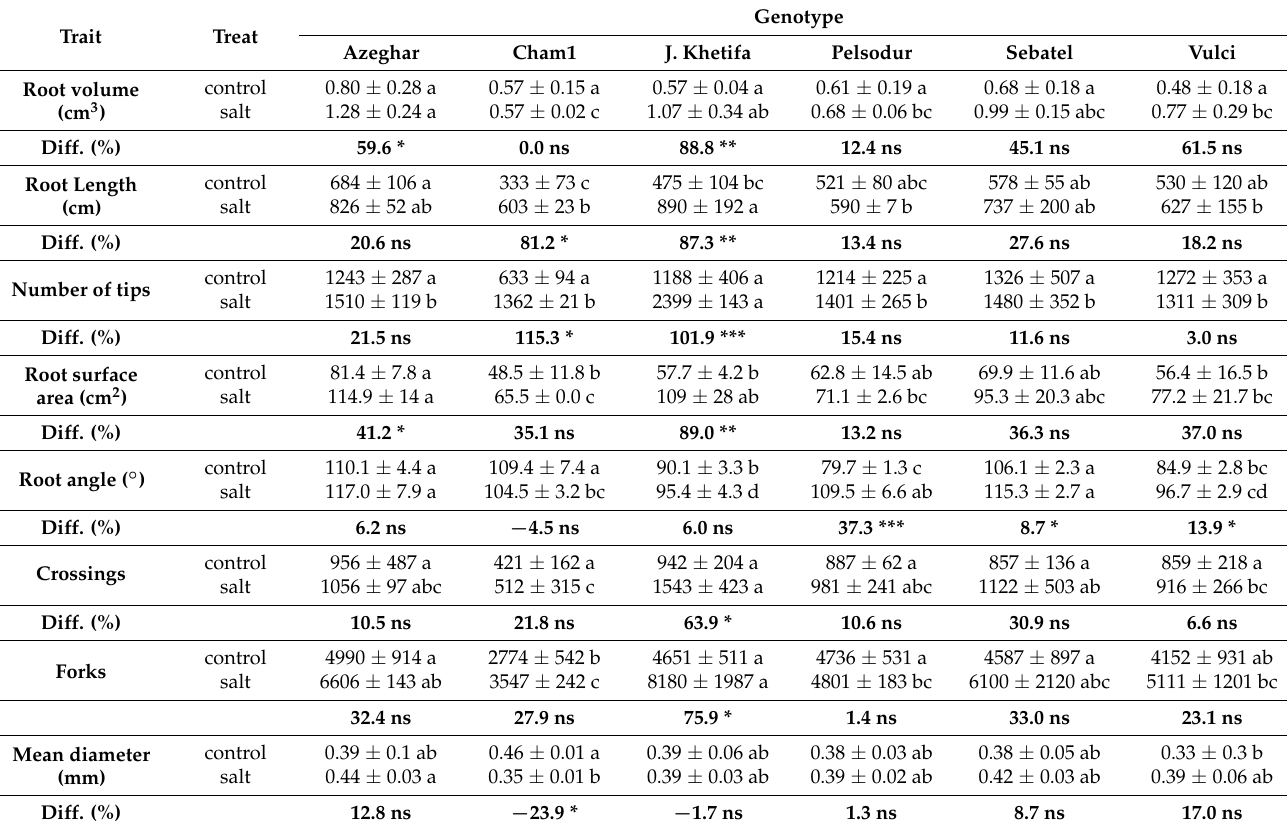
Table 3. Salt versus control effect on root traits of six durum wheat